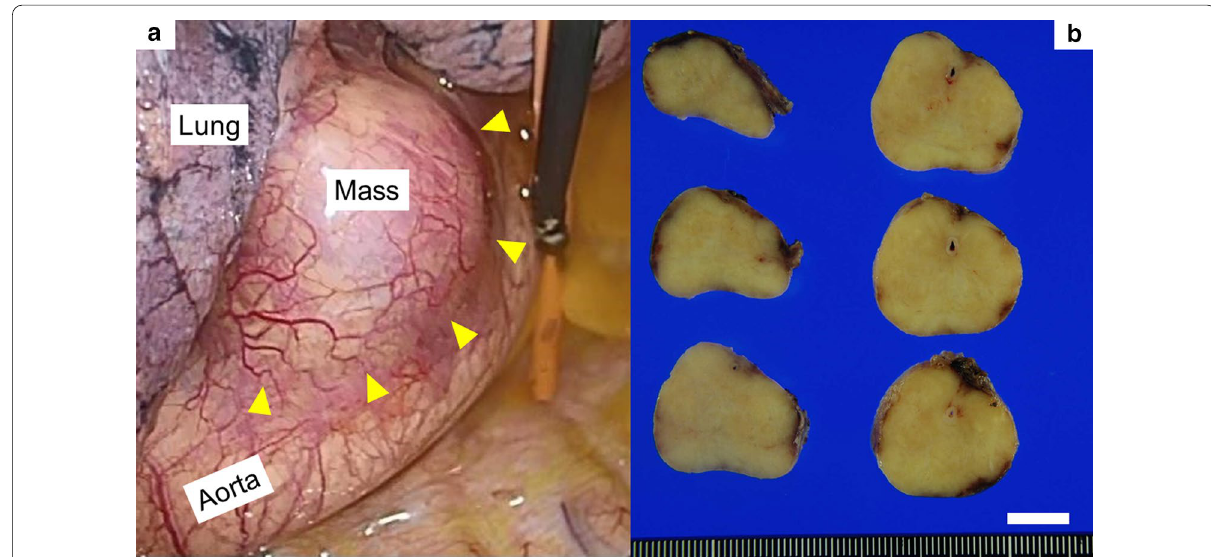
Fig. 2 Intraoperative view of the left-side mediastinum and macroscopic findings of the mediastinal mass. a Intraoperative view showed that the mass was well-encapsulated neighboring to the aorta (yellow arrowheads). b Cross section of the mediastinal mass was elastic and homogenous yellowish; white bar 1 cm =